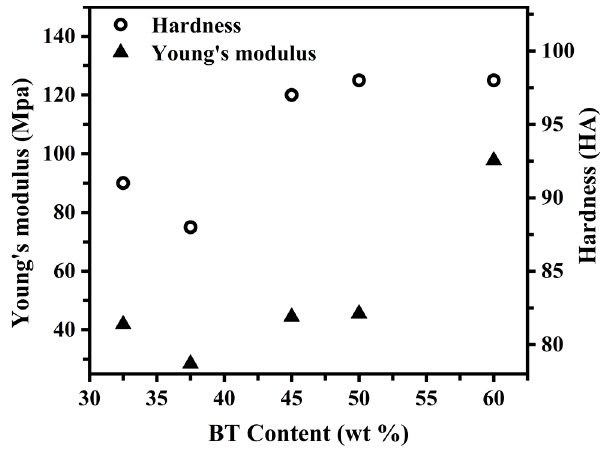
Figure 5. Young’s modulus and hardness of PBST copolymers with different BT contents.